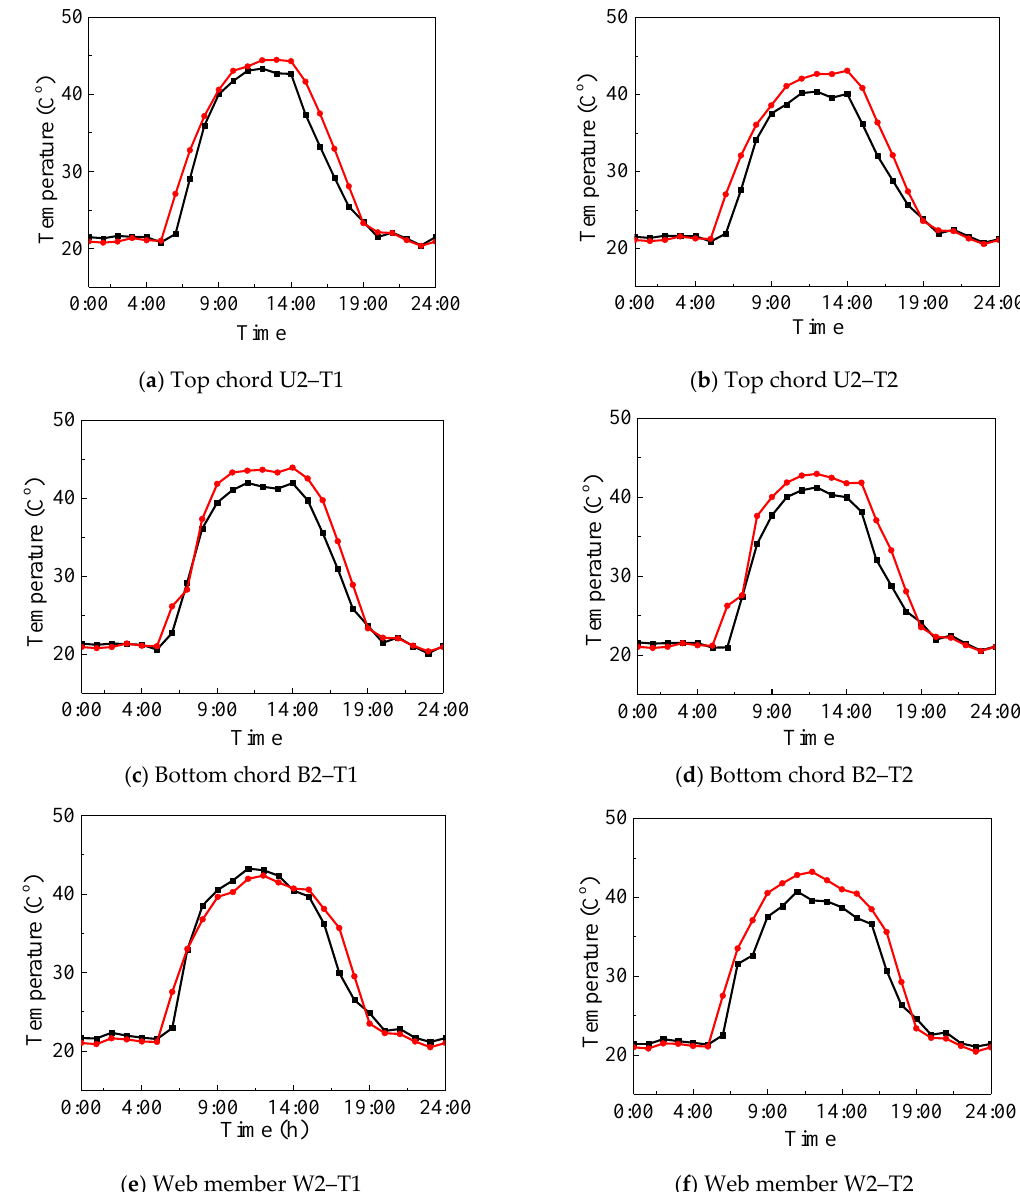
Figure 11. Comparison between the simulation value and the measured value at the measuring point. Red and black lines indicate the simulated and measured results, respectively. Red and black lines indicate the simulated and measured results,